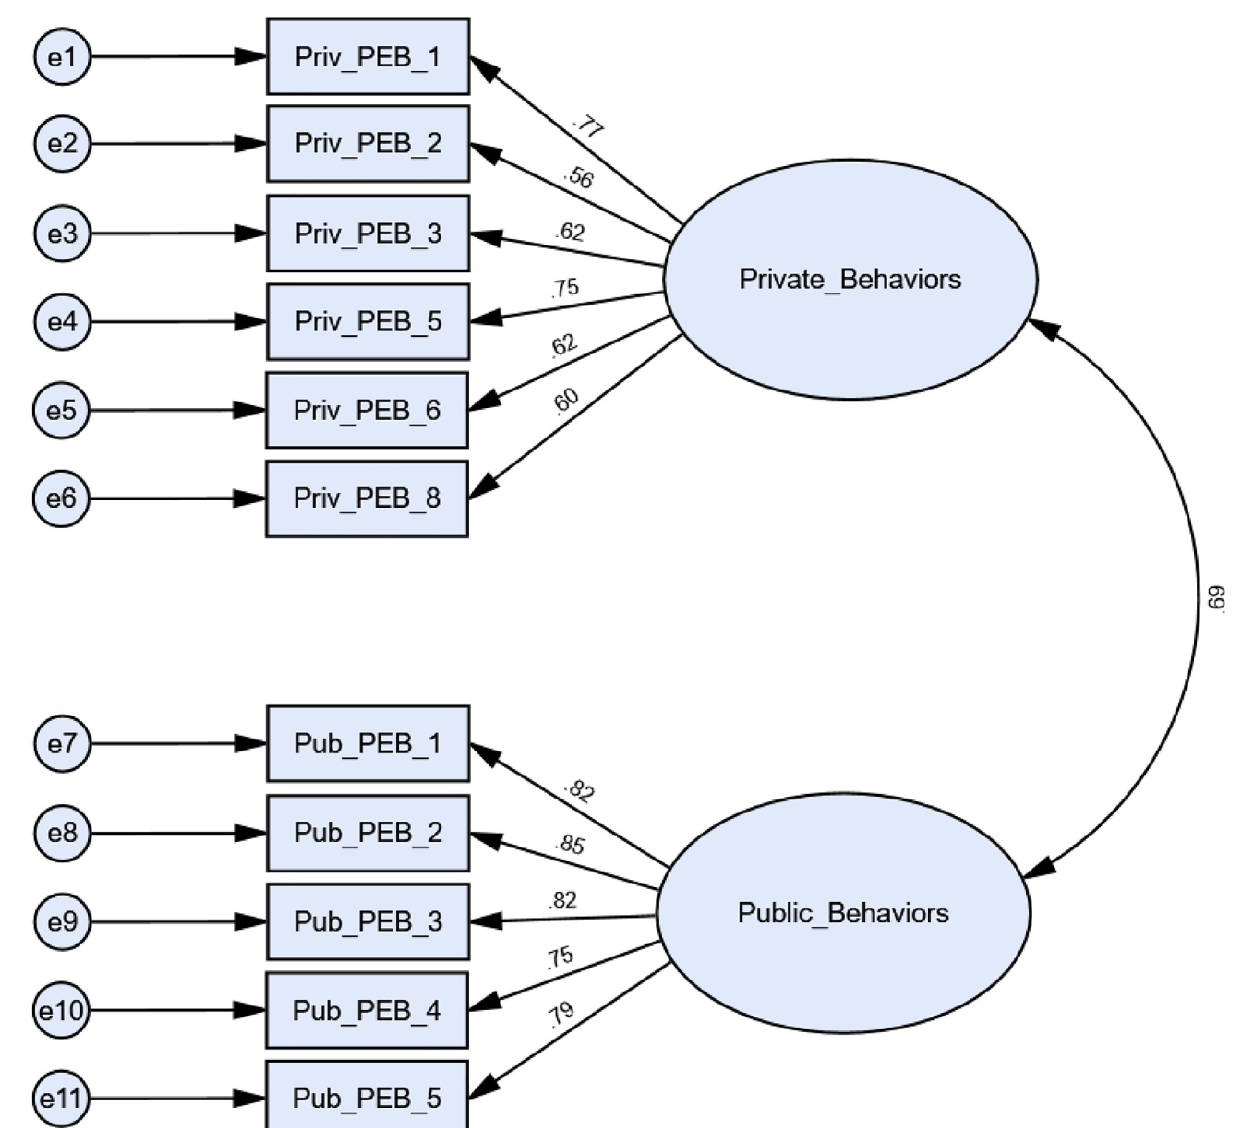
Fig 1. Confirmatory factor analysis diagram for QUAL with standardized estimates; global fit indices: S 2 = 211.082, df = 43, p < 0.001; RMSEA = 0.061; SRMR = 0.044; CFI = 0.969.